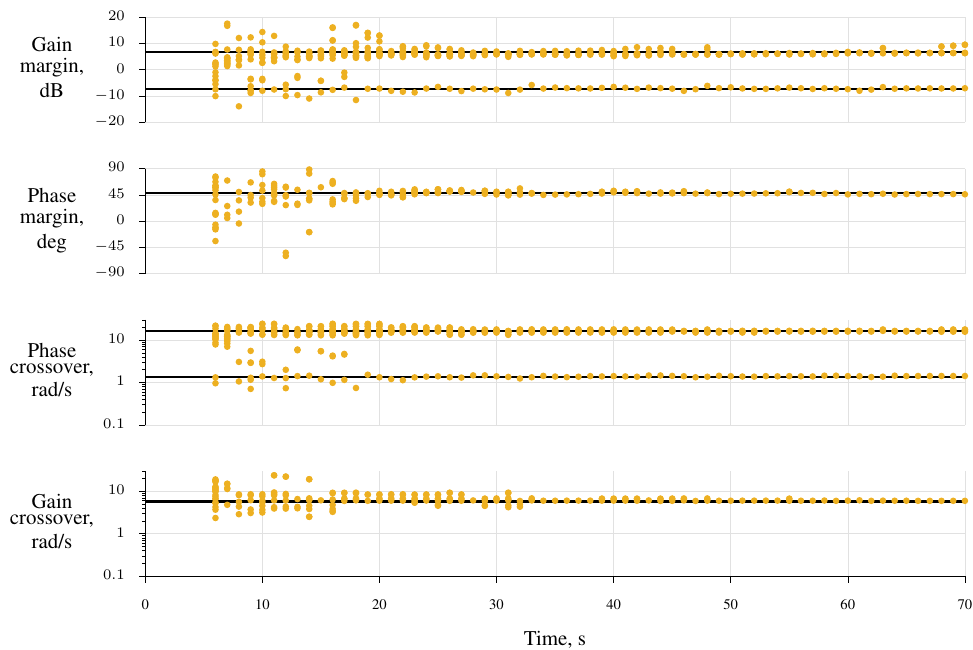
Figure 12. The real-time stability margin estimates for the X-59 stabilator loop, showing true values (black lines) and real-time estimates updated at 1 Hz (yellow